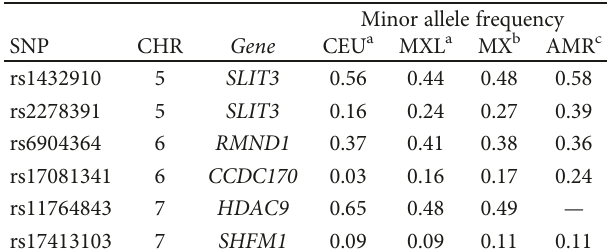
Table 2: Allele frequency of SNPs associated with BMD phenotypes in the discovery sample and comparison with other